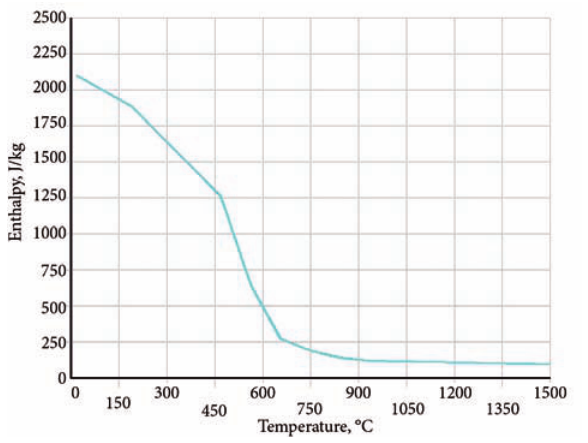
Fig. 7. Steel S355 J2 Young’s module reliance on